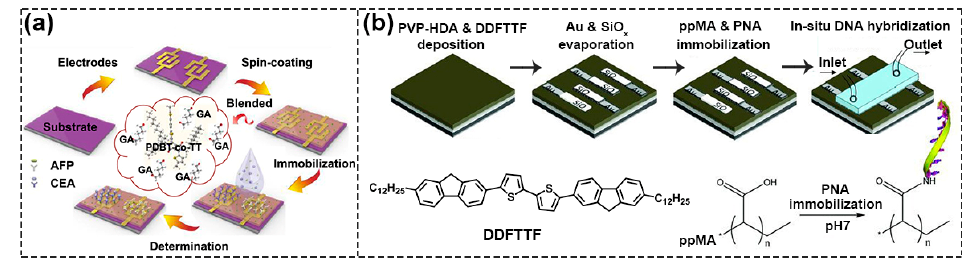
Figure 3. Schematic diagram of physical functionalization methods. ( a ) Flow chart of PDBT–co–TT/GA blend films. Reproduced with permission from [21]. Copyright 2021, American Chemical Society. ( b ) Process of deposition of a functional layer containing carboxyl groups on DDFTTF semiconductor surface by polymerization of MA monomer. Reproduced with permission from [22]. Copyright 2010, John Wiley and